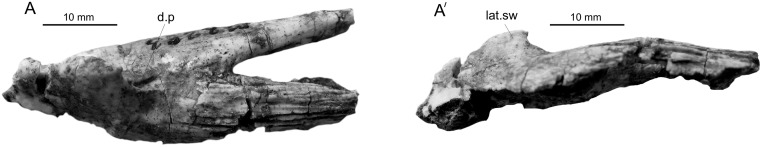
Axelrodichthys megadromos, Cruzy—Massecaps (M2253).Left dentary in lateral (A) and ventral (A’) views. Abbreviations: d.p, enlarged sensory pore; lat.sw, lateral swelling.